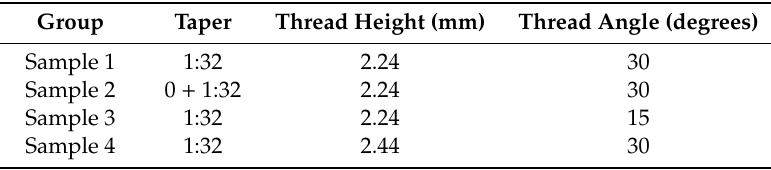
Figure 19. Test samples. Table 2. Structural parameters of the test samples.